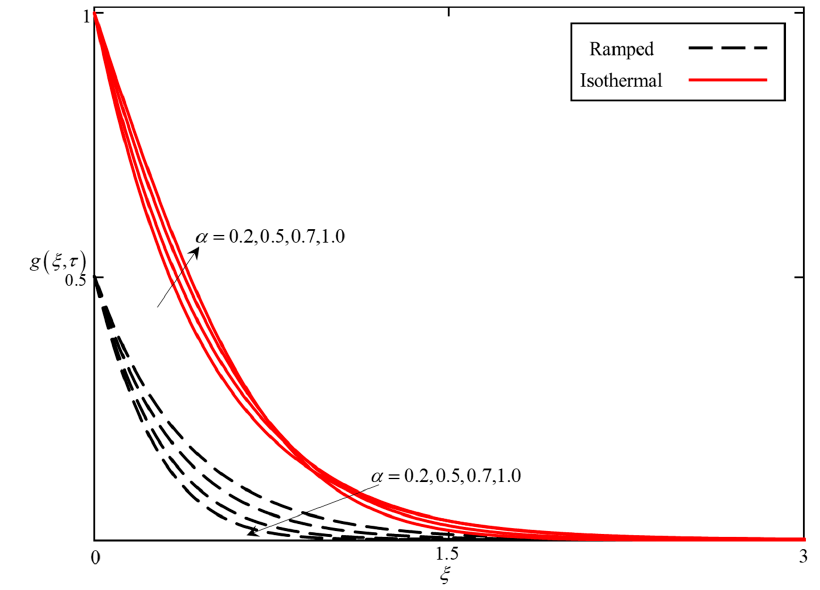
Figure 5. Consequence of α on the temperature field, when φ = 0.04 and Pr =